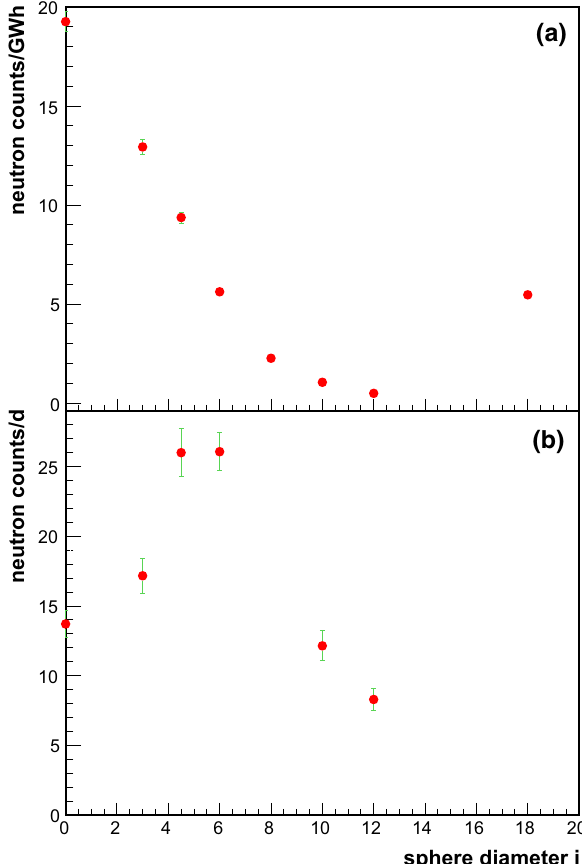
Fig. 12 Neutron counts in the individual Bonner spheres, as a function of the sphere diameter i . The data point at i = 0 corresponds to the bare detector.Thedatapointat i = 18correspondstothe8”modifiedsphere. a Data from DS-3 (reactor ON), normalized to 1GWh of the reactor energy output E KBR according to Eq. (4). b Data from DS-2 (reactor OFF), normalized as counts per 24h. The error bars are in some cases smaller than the size of the